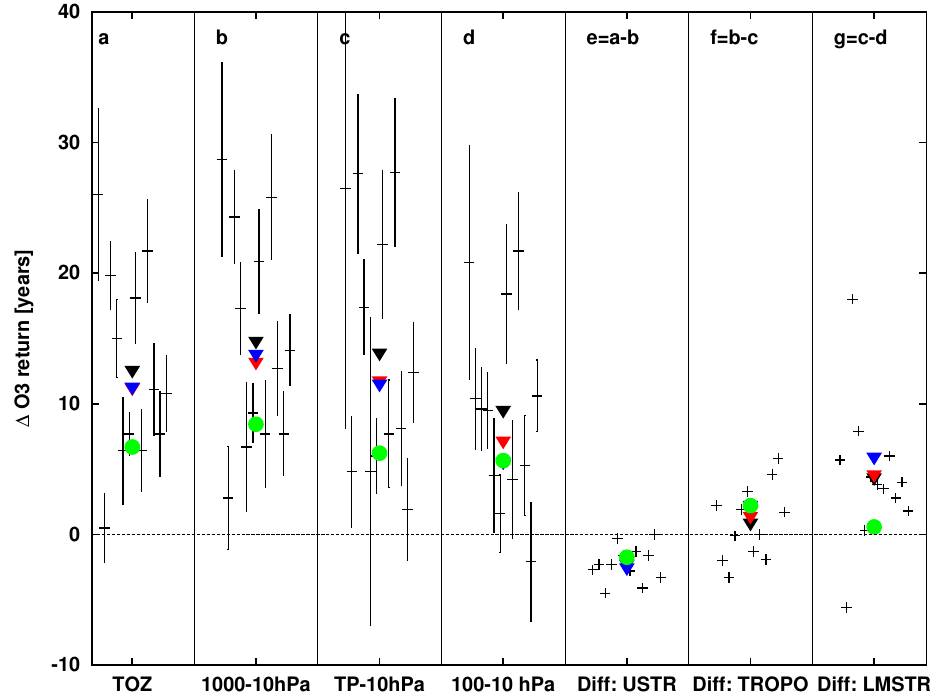
100-10 hPa Diff: USTR Diff: TROPO Diff: LMSTR Fig. 3. Hemispheric difference ((45 to 60 ◦ S) − (45 ◦ to 60 ◦ N)) in return dates of ozone to 1980 values for twelve different models (back crosses with uncertainty bars) and the multi-model mean (triangle) for (a) total column ozone, and partial column ozone (b) from the surface to 10hPa, (c) from the tropopause to 10hPa and (d) 100hPa to 10hPa. Furthermore the impact on hemispheric differences in return dates from the upper stratosphere ( e = a–b ), from the tropopause ( f = b–c ) and from the lowermost stratosphere ( g = c–d ) is shown. Multi-model means are also shown for the two additional methods described in Appendix A: method 2 (red) and 3 (blue). The green markers indicate the hemispheric difference in return dates that would result if the linear trend in the NH was the same than in the